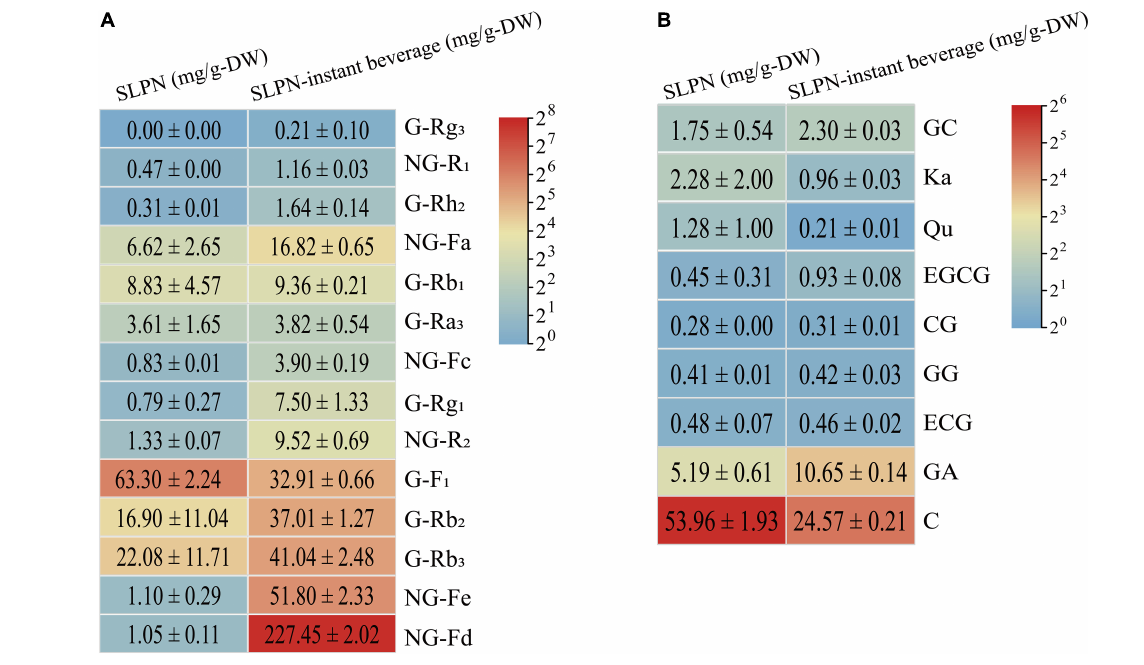
FIGURE5 The contents of (A) fourteen saponin and (B) nine polyphenols in SLPN and SLPN-instant beverage.